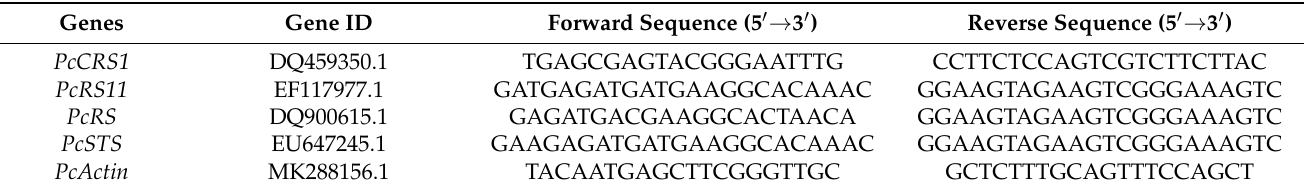
Table 1. Primer sequences of the genes used in the present study for qRT-PCR.